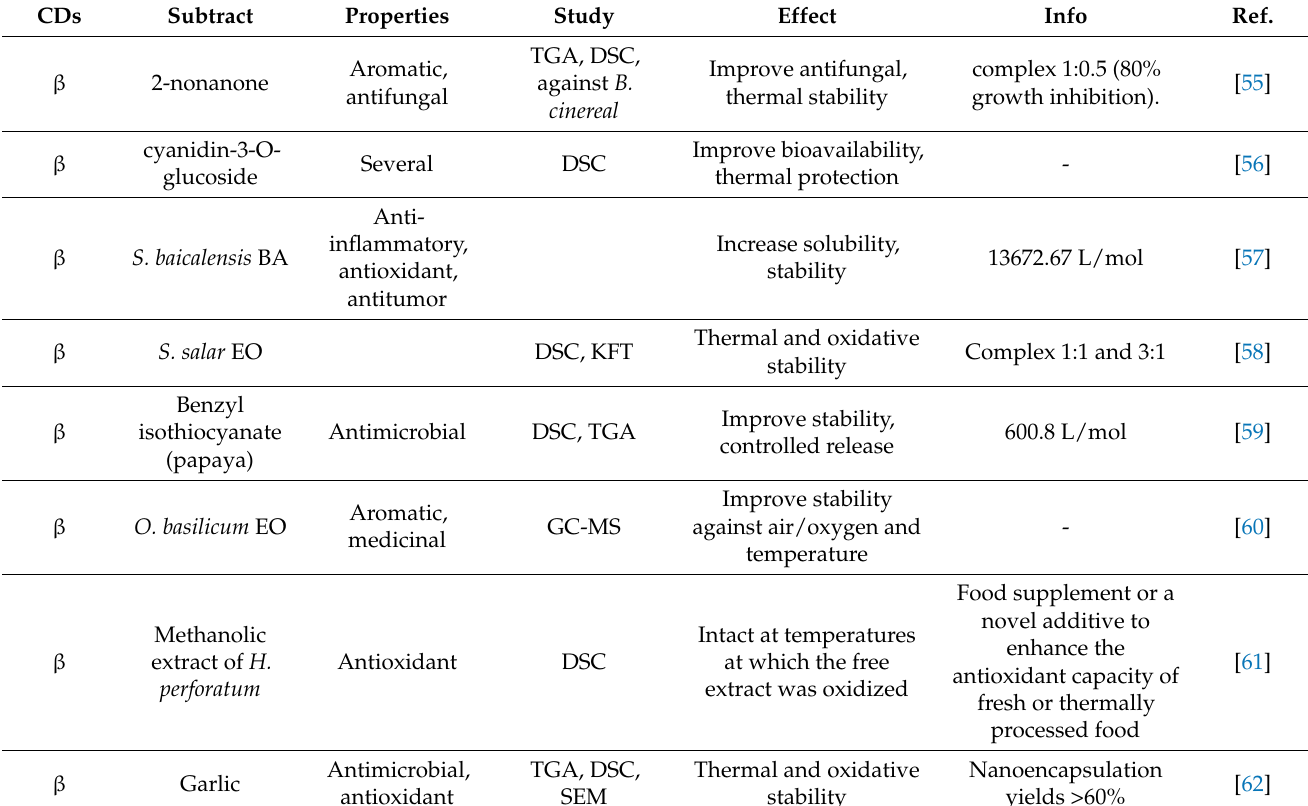
Table 3. Studies of cyclodextrins (CDs) for heat protection of food